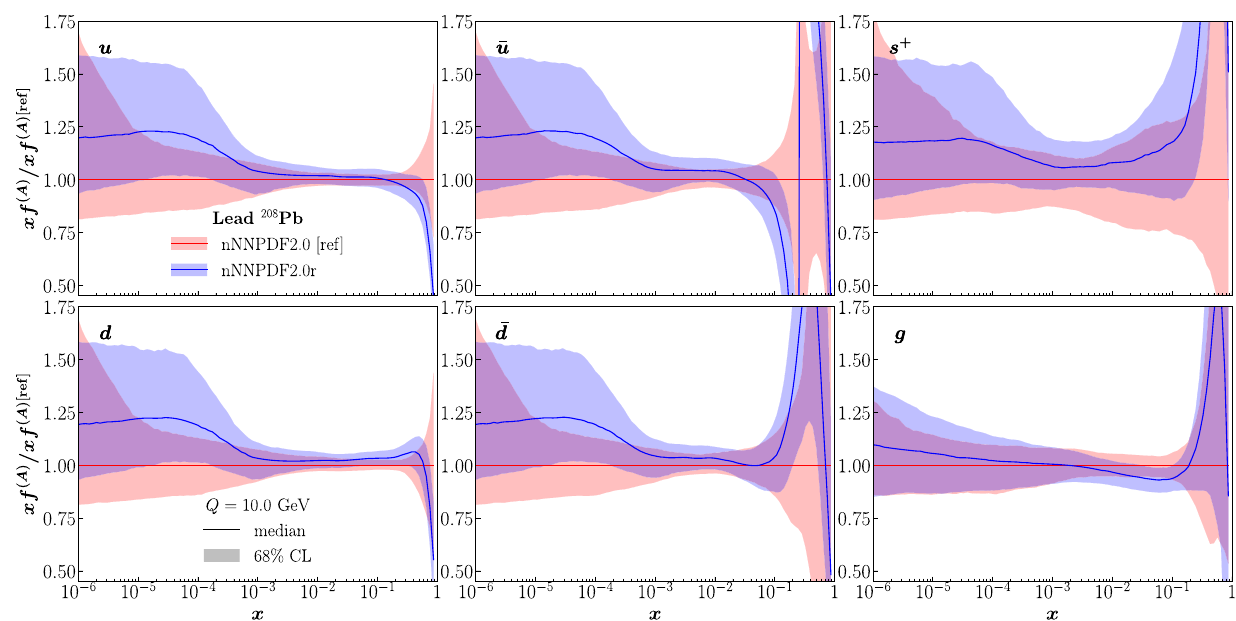
Fig. 20 Comparison of nNNPDF2.0 with the nNNPDF2.0r variant. Results are shown for the lead PDFs at Q = 10 GeV normalised to the central value of nNNPDF2.0, and the uncertainty bands represent the 68% CL